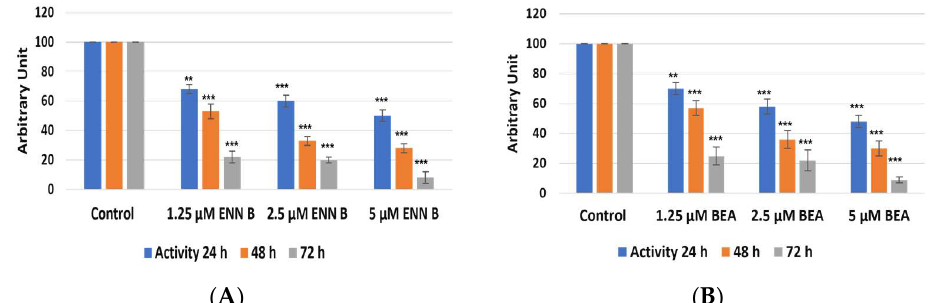
Figure 9. Impact of ENN B and BEA on proteolytic activities of cathepsin B in cellular extracts. ( A ) Cathepsin B activities were measured in cellular extracts using cathepsin B specific substrate Z-R-R.AMC in cellular extracts after treatment with different concentrations of ENN B at different times. ( B ) Cathepsin B activities were measured in cellular extracts after treatments with different concentrations at different times with BEA. The data were analyzed using two-way ANOVA with Dunnett’s post hoc analysis (** p < 0.01; *** p < 0.001; N = 7). Statistics were calculated using GraphPad Prism.